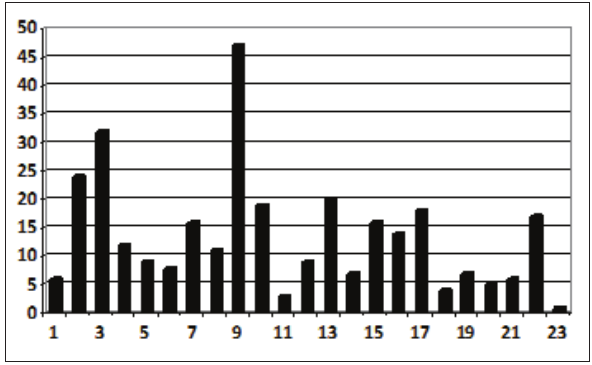
Fig. 1. Duration of therapy of 23 patients during the admin- istration of metipranolol 2 times 10 mg per day expressed in weeks.